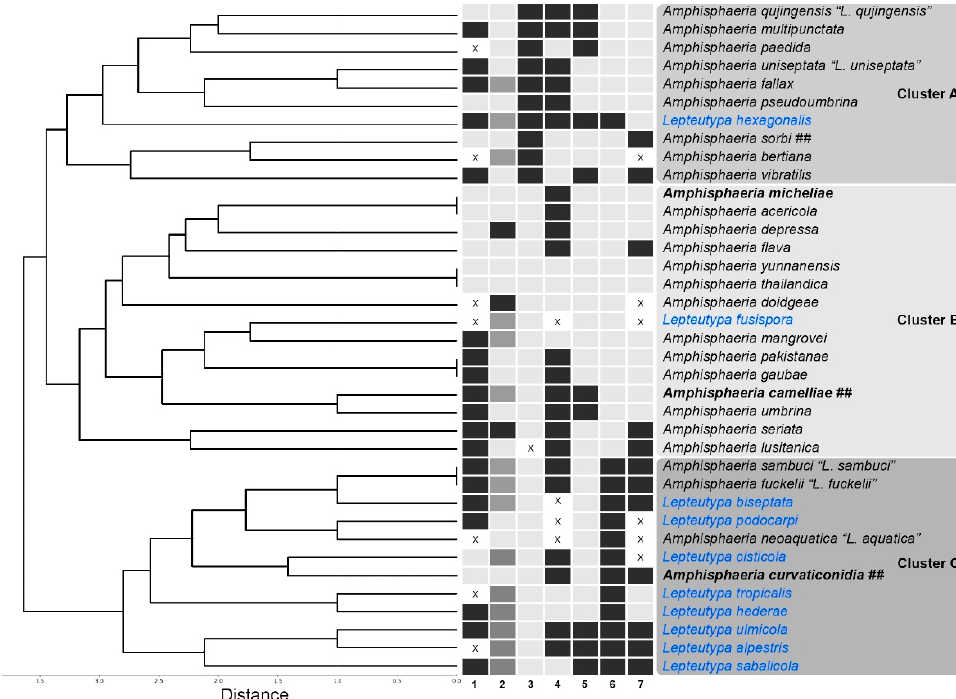
Figure 2. Cluster analysis dendrogram showing similarity among Amphisphaeria and Lepteutypa species (linkage algorithm paired group UPGMA; Average Distance measure). Characteristics: (1) nature of the clypeus; (2) nature of the ascomata; (3) l / w ratio of asci; (4) apical ring; (5) l / w ratio of ascospores; (6) ascospore septation; and (7) mucilaginous sheath around ascospores. “X” denotes missing data. Newly introduced species are in bold. Taxa which needed to be revised are in blue. Holomorphic taxa are denoted as “##”.